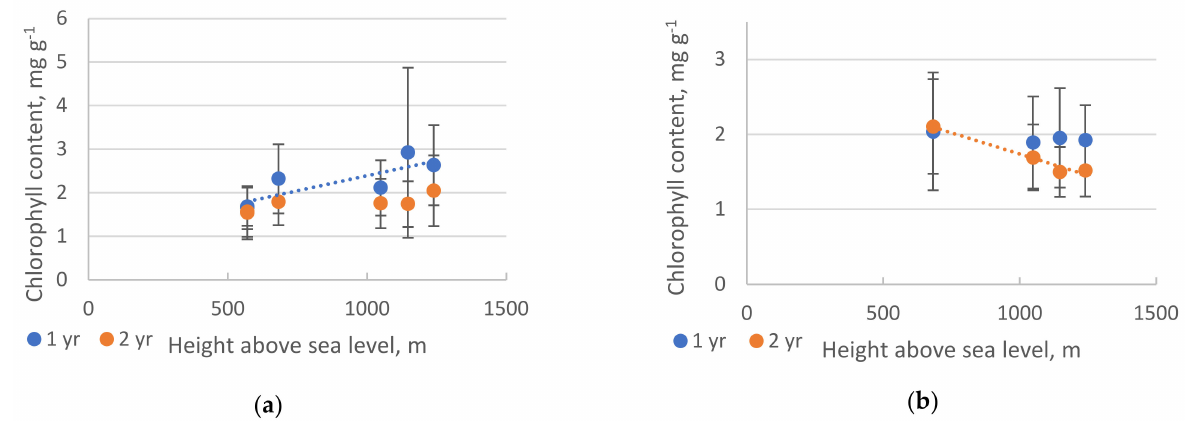
Figure 4. Chlorophyll content (dry weight) in needles of P. sibirica ( a ) and A. sibirica ( b ). The significant slopes are shown on the graph. Pearson analysis revealed significant linear regression in P. sibirica for one–year–old needles and in A. sibirica for two–year–old needles ( p < 0.05). The vertical bars represent the standard deviation. At each sample point, 15 measurements of both one– and two–year–old needles were